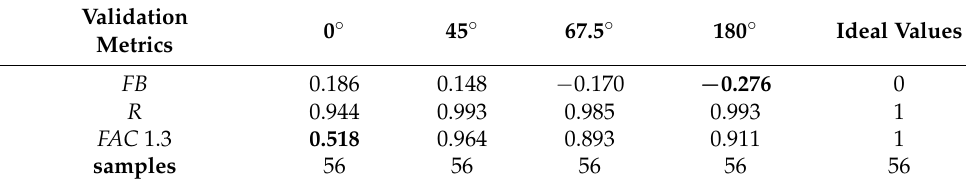
Table 1. Validation metrics calculated for high-rise building with an exoskeleton structure.